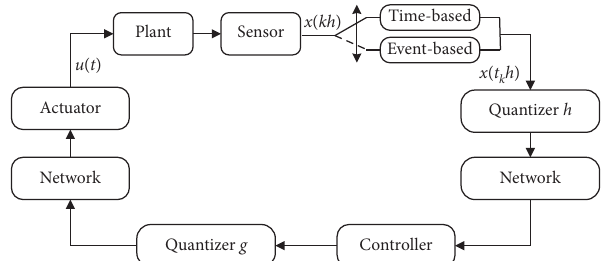
Figure 1: The structure of the Markov jump system with hybrid- driven